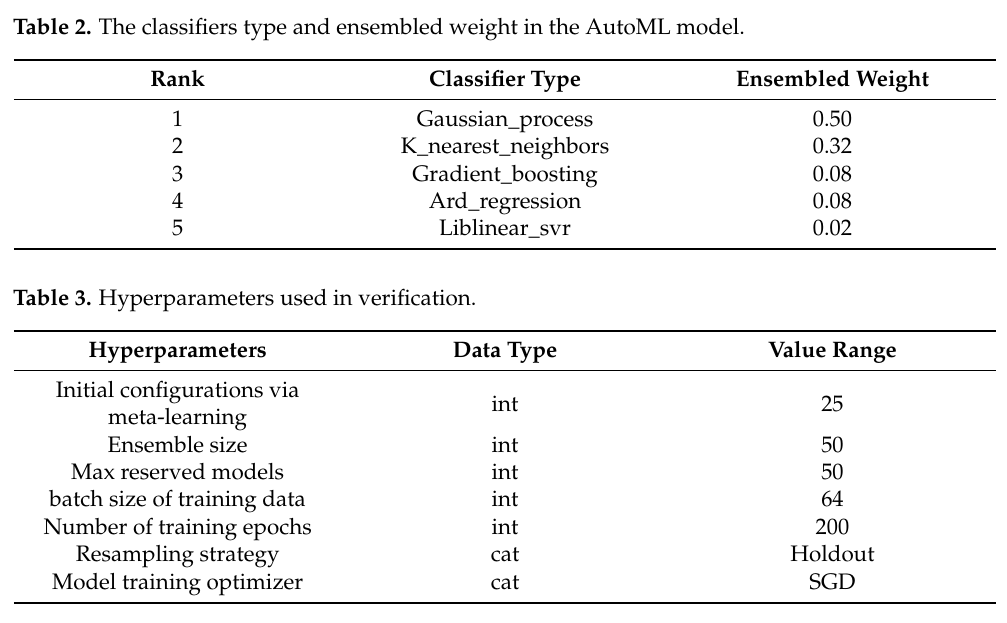
The capacity prediction and relative error of B05, B06, B07, and B18 are depicted in Figure 9. The red predicted capacity curve approximates the yellow real capacity curve with most prediction errors controlled within 7% in the validation of four batteries, indicating high accuracy and robustness.